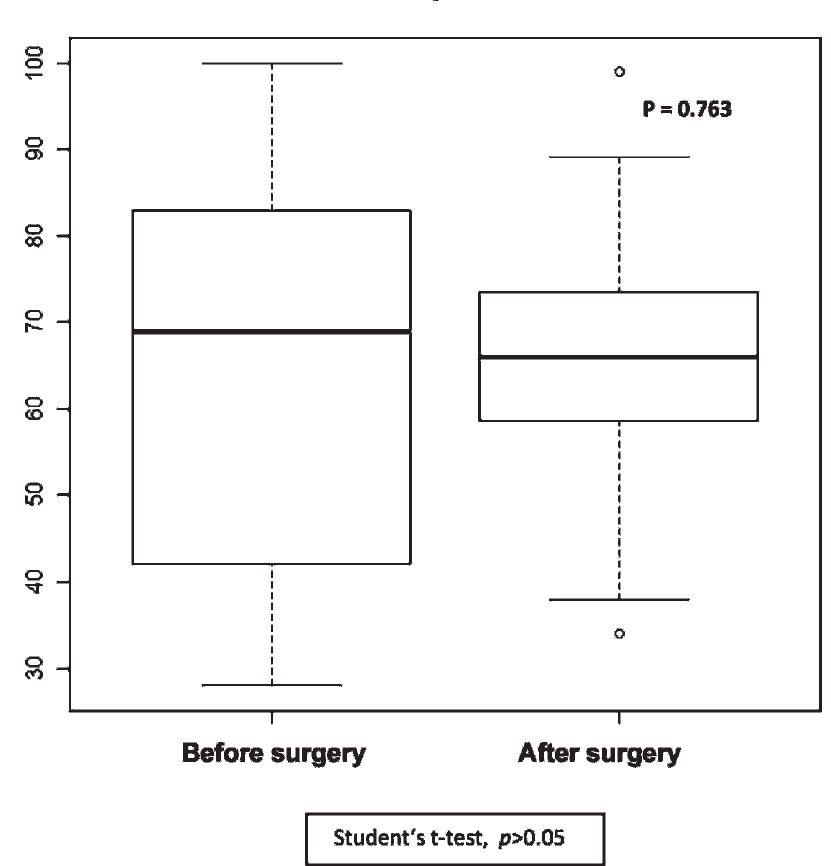
Figure 3 - Resting pressure before and after surgery in 23 patients who underwent perineal